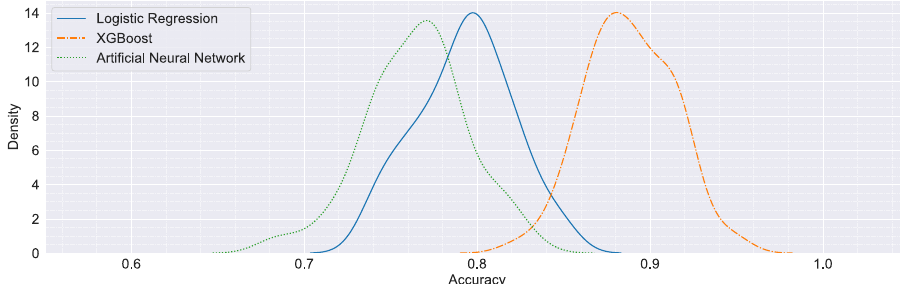
Figure 10. Accuracy of Machine Learning Models.